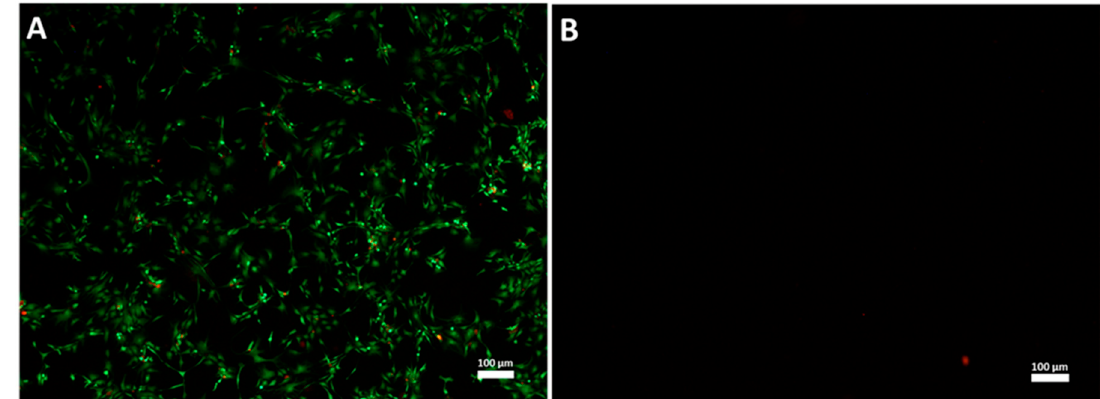
Figure 3. Example of Live/Dead staining of digested cartilage: After the conditioning of medium for 35 days cartilage (vital and pressure treated) was digested and the retrieved cell suspension was cultured for 8 days. Live/Dead staining was performed with cells cultured from digested vital cartilage (VC) ( A ) or high hydrostatic pressure treated cartilage (HHPTC) ( B ). Live cells appear green and dead cells appear red. Magnification: 40×, scale bar: 100 μ m.